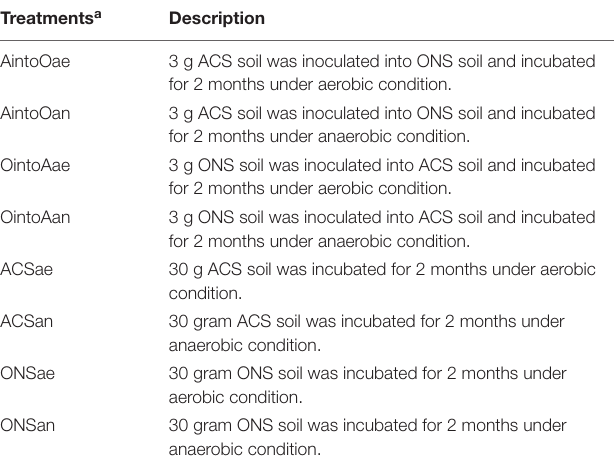
TABLE 1 | Experimental design of reciprocal